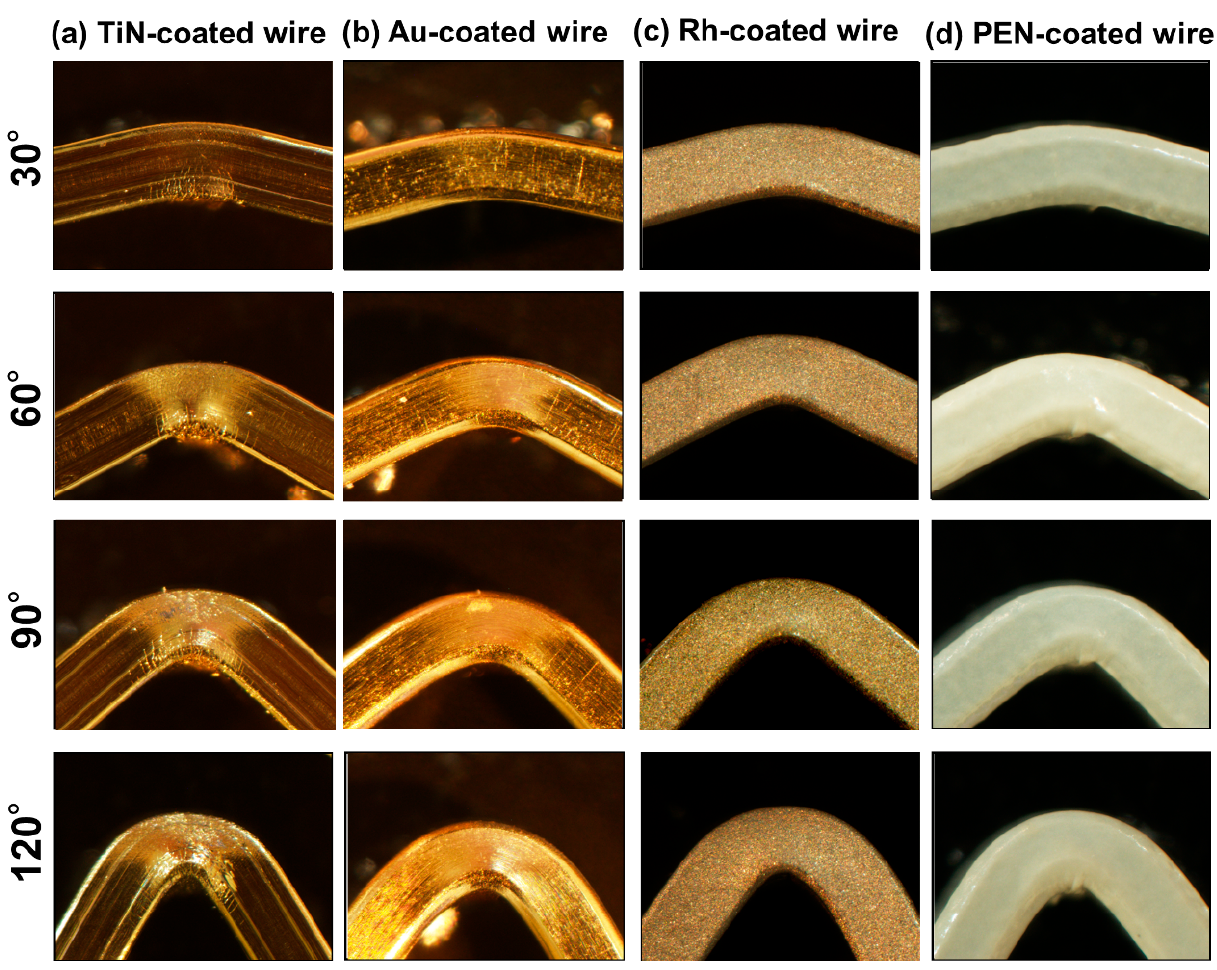
Figure 3. Stereomicrographs of four types of coated wire with various bend angles from 30° to 120°: ( a ) TiN-coated wire; ( b ) Au-coated wire; ( c ) Rh-coated wire; ( d ) PEN-coated wire.